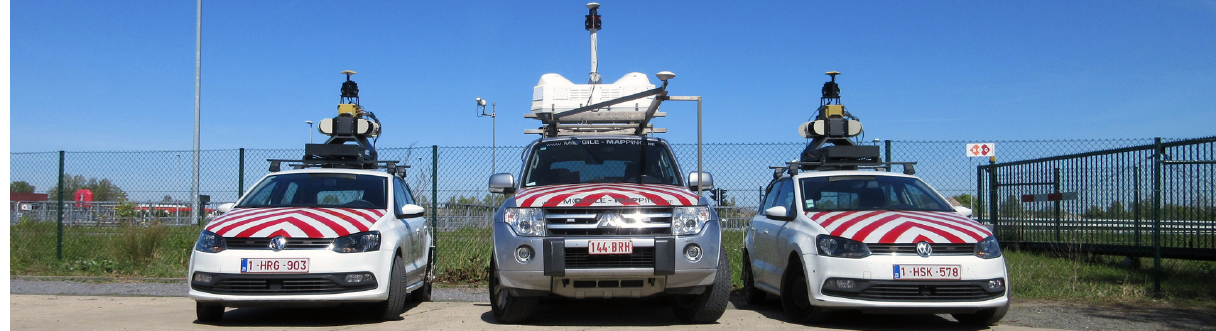
Figure 1. Example Mobile Mapping Systems: IP-S2 Compact system (left and right) and Lynx mobile mapper system (centre).